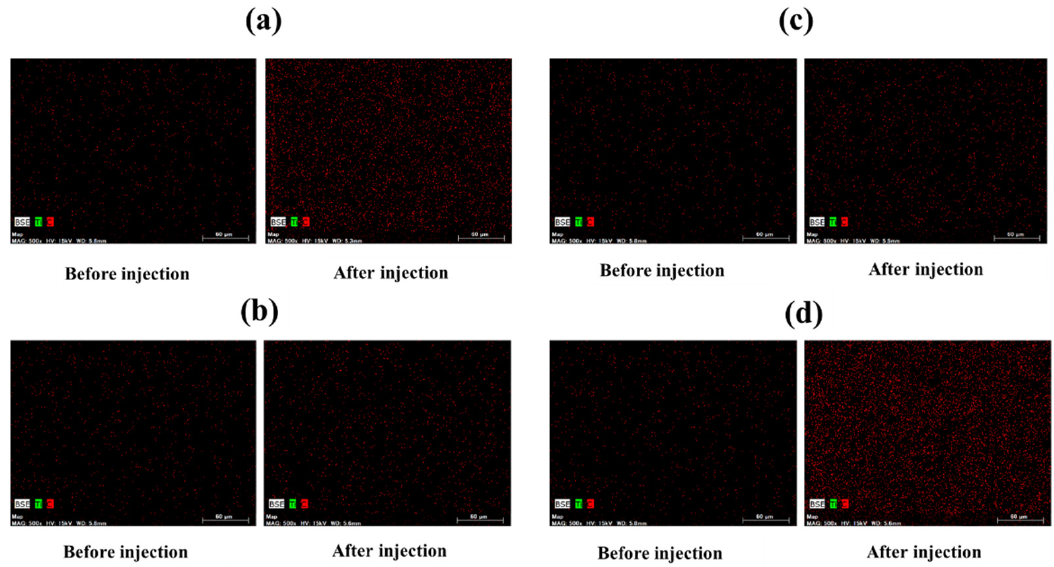
Figure 13. Elemental analysis images before and after agar particle blasting are shown: ( a ) S-6, ( b ); WH-706, ( c ); WH-708, ( d ); WH-709 polishing compared with before adhesion. Compared with the other four types of agar, the amount of carbon after blasting was the lowest.